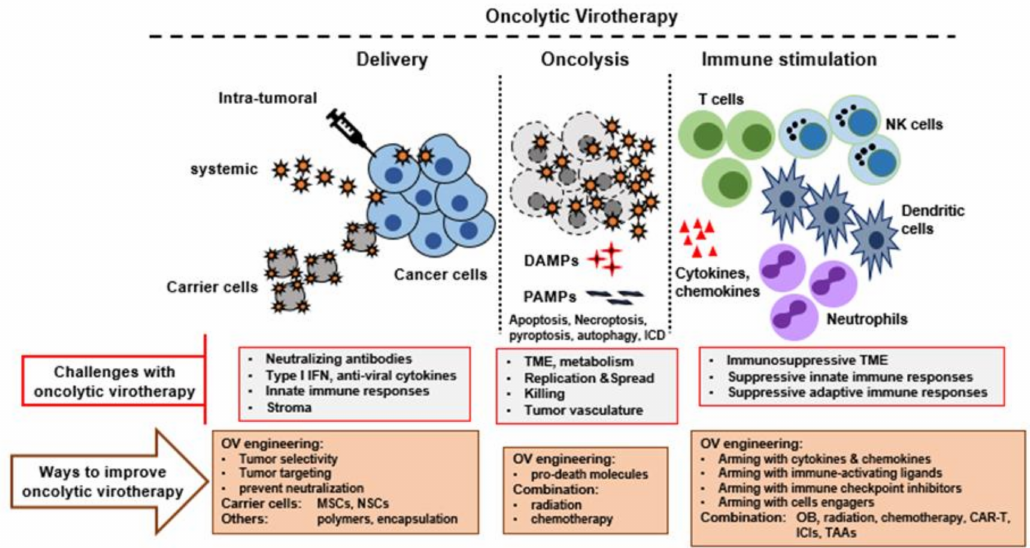
Figure 1. Therapeutic features of oncolytic virotherapy and ways to improve it. Multiple steps are involved in successful oncolytic virotherapy. First, the virus must be delivered successfully to the tumor bed or TME using an optimized delivery method. Second, the OV must replicate and spread efficiently in the tumor bed, causing oncolysis and release of tumor selective immune stimulating molecules. Third, the OV must function as an immunotherapeutic agent to activate strong innate and adaptive anti-tumor immune responses. All these steps can be further improved by engineering OVs to express suitable transgenes and by combination with other agents or therapies. TME, tumor microenvironment; DAMPS, danger associated molecular patterns; PAMPs, pathogen associated molecular patterns; ICD, immunological cell death; MSCs, Mesenchymal stem cells; NSCs, neural stem cells; ICIs, immune checkpoint inhibitors; TAAs, tumor associated